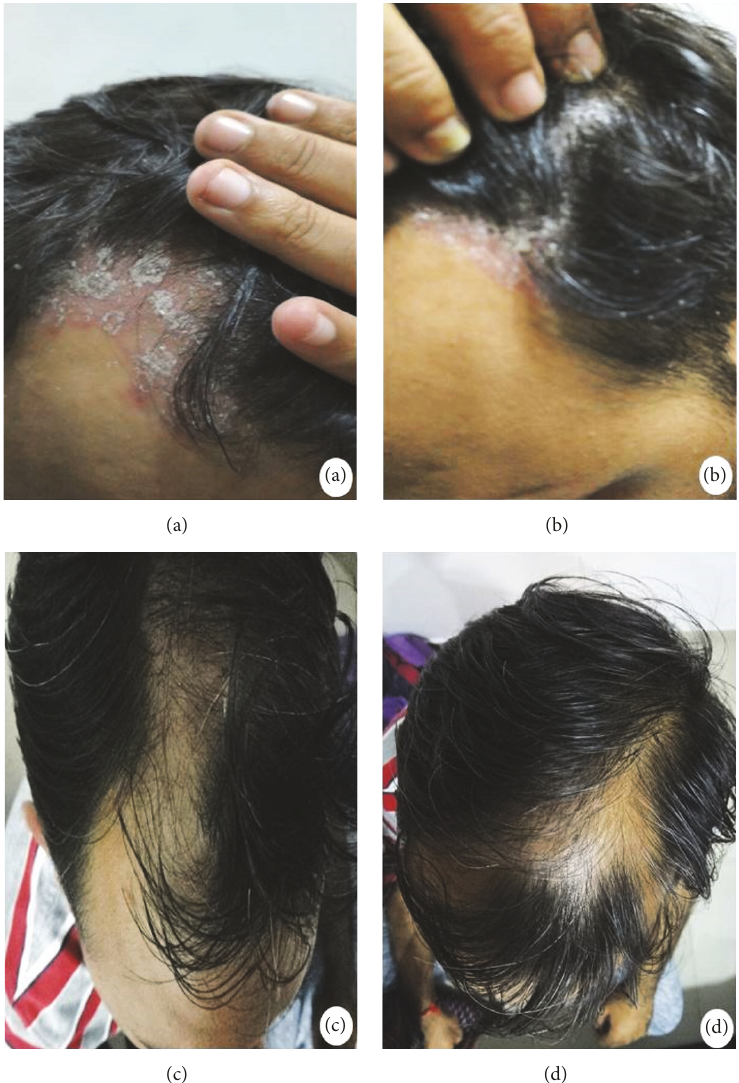
Figure 2: Effect of MSC-CM on psoriasis vulgaris . The scalp of patient showing numerous erythematous plaques with adherent silvery flakes before MSC-CM-treatment (a, b). Regression of psoriasis and a complete clearance of inflammatory erythematous plaques recorded after topical application of MSC-CM for a period of one month (c,